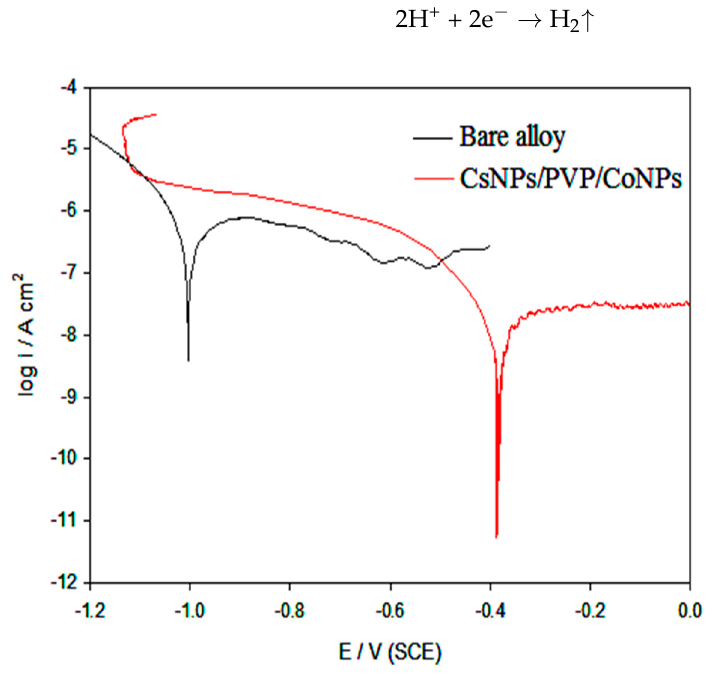
Figure 8. Tafel plots for bare Ti alloy and a CsNPs/PVP/CoONPs-coated Ti alloy after immersion in artificial saliva at 37 °C.